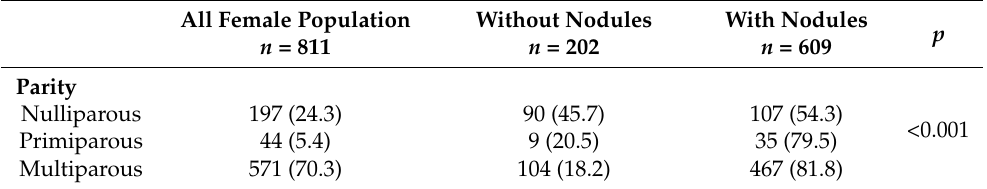
Table 2. Gynecological status for all female patients and according to the presence of thyroid nodule. All Female Population n = 811